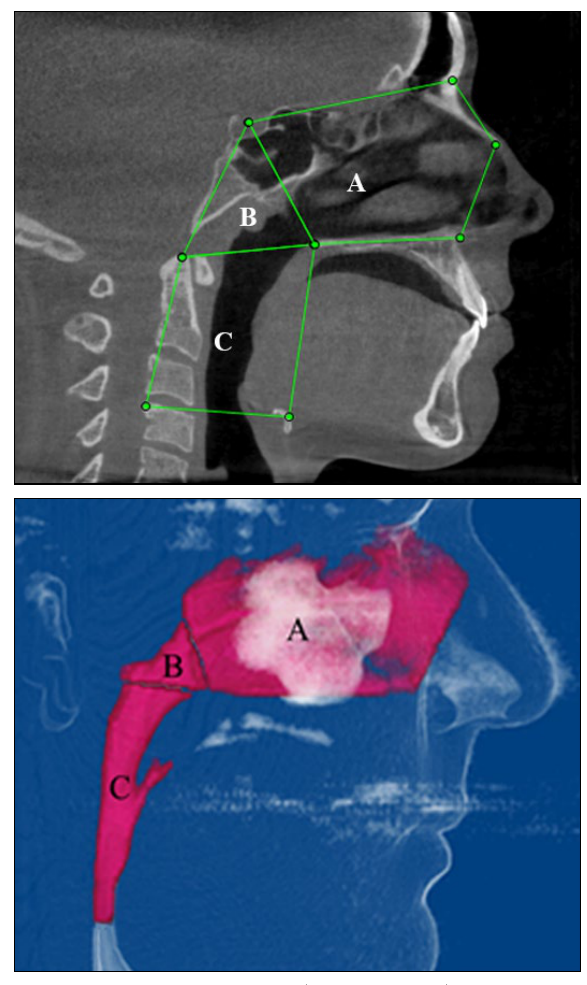
Figure 2. Airway segments; (A) nasal cavity; (B) nasopharynx; (C)